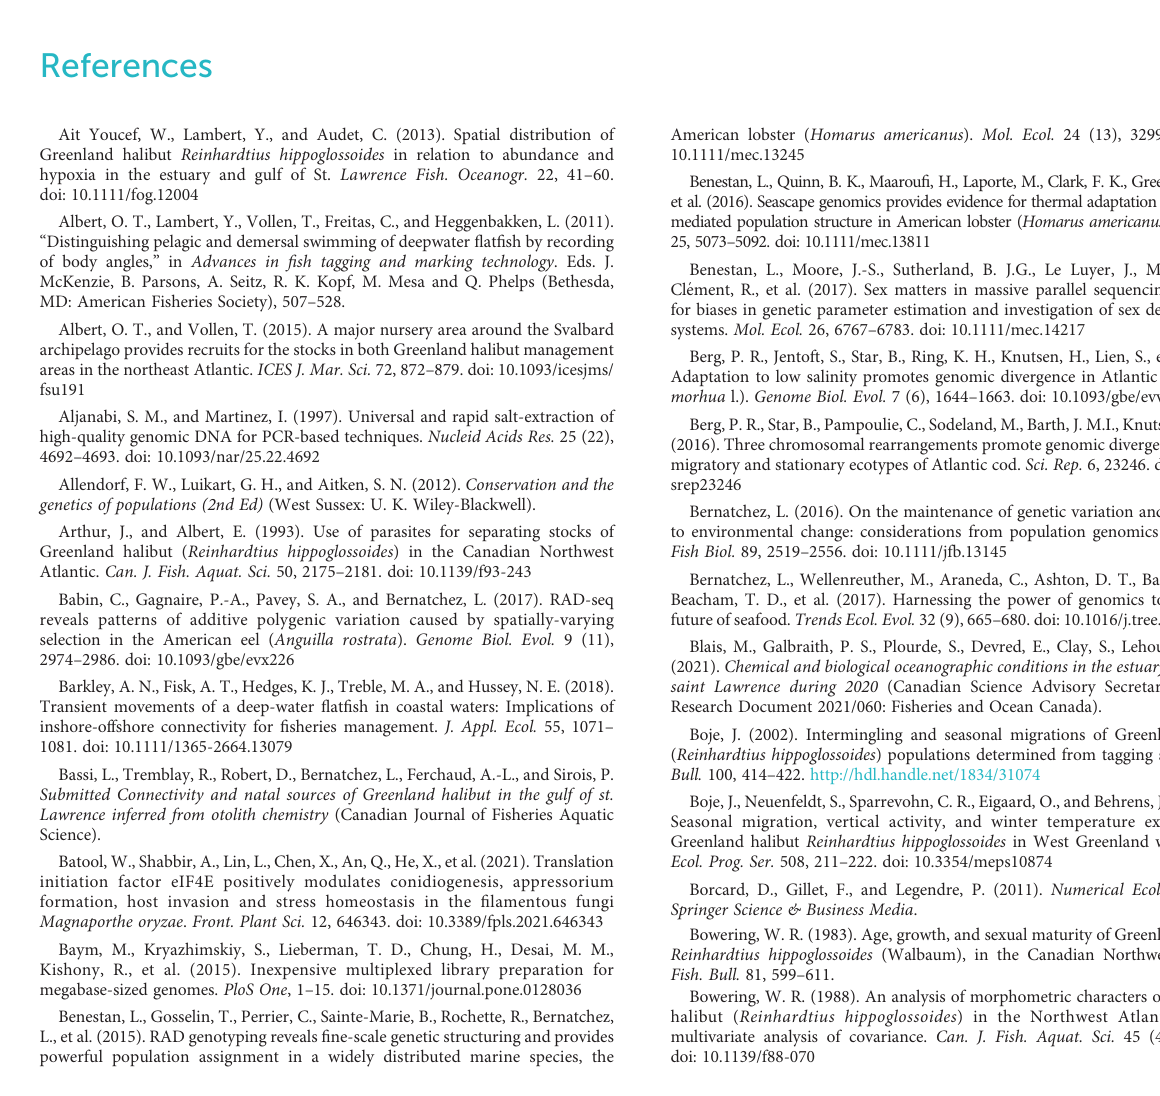
SUPPLEMENTARY FIGURE 4 Local PCA conducted for each of the outlier window detected by the Lostruct analysis. Despite the detection of three clusters within these windows, no geographical structuration is distinguishable. Therefore, those putative inversions are unlikely to be involved in the Gulf- Northwest Atlantic differentiation.